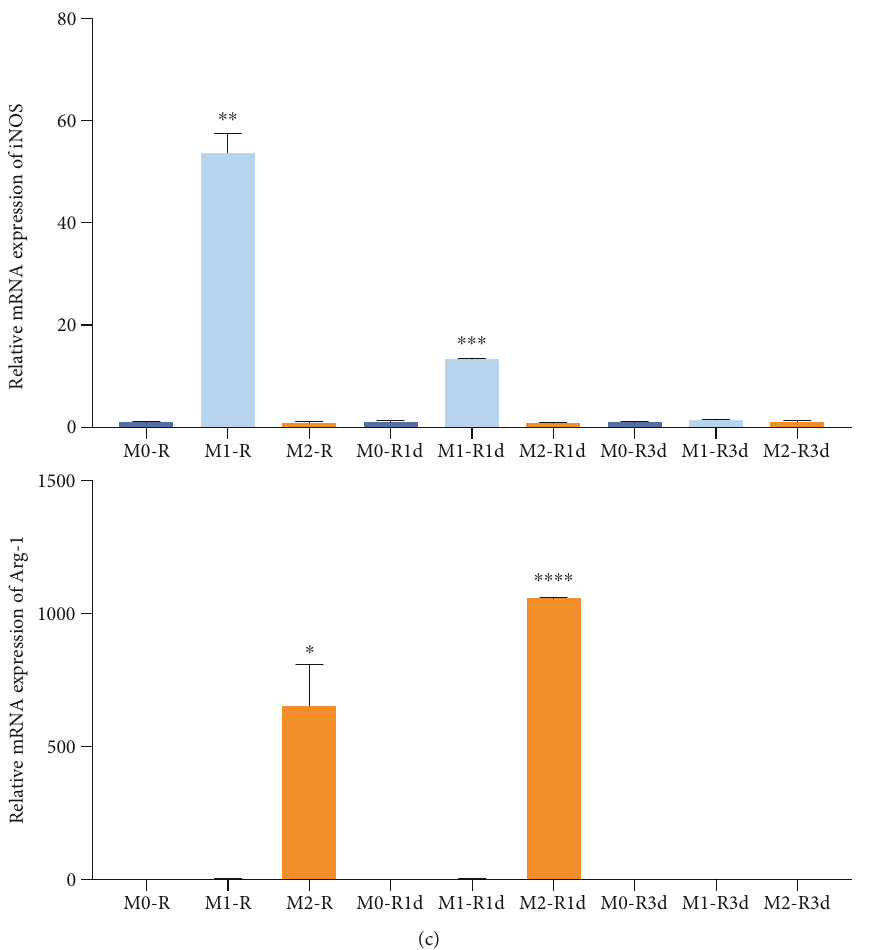
Figure 1: Polarization of macrophages. (a) Representative chemiluminescent images of western blot analysis of iNOS, Arg-1, and β -actin in untreated macrophages (referred to as M0-R) and macrophages undergoing M1 or M2 polarization (referred to as M1-R and M2-R). (b) Western blot analysis of iNOS and Arg-1. The gray value was calibrated using β -actin. (c) The mRNA expression levels of iNOS and Arg-1 in macrophages untreated or undergoing M1 or M2 polarization immediately (referred to as M0-R, M1-R, and M2-R) or 1 day later (referred to as M0-R1d, M1-R1d, and M2-R1d) or 3 days later (referred to as M0-R3d, M1-R3d, and M2-R3d). ∗ P < 0 : 05 , ∗∗ P < 0 : 01 , ∗∗∗ P < 0 : 001 , and ∗∗∗∗ P < 0 : 0001